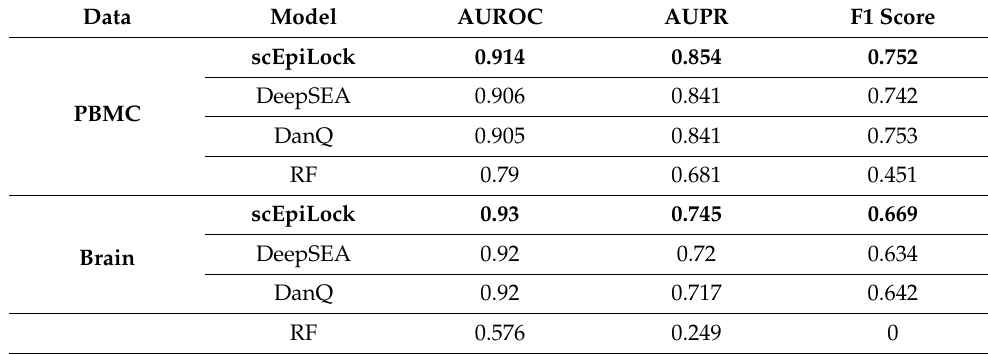
Table 1. Model performance comparison. scEpiLock has the best performance on both